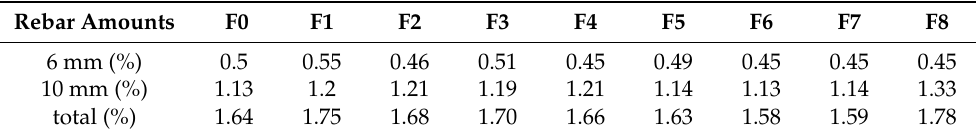
Table 1. The percentages of the 6 mm, 8 mm and entire steel rebar in each joint, compared with the concrete